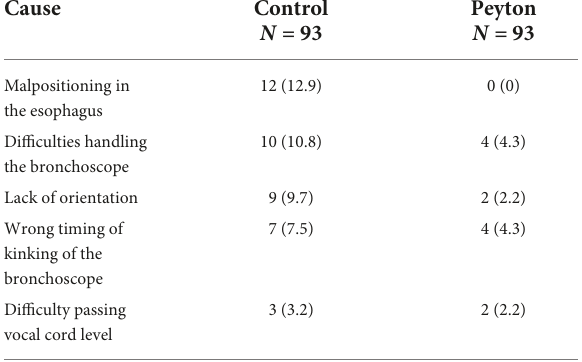
TABLE 2 FAST failure causes by